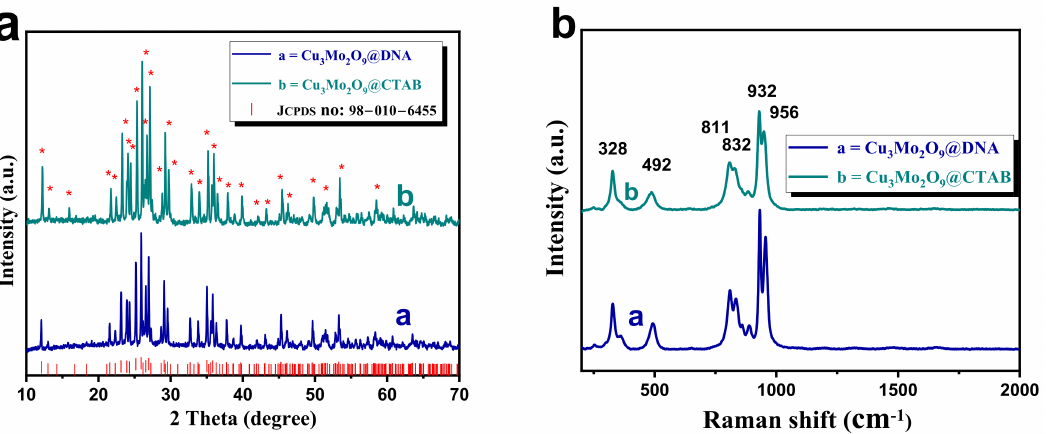
Figure 2. ( a ) Stacked XRD (diffraction peaks marked with red asterisks (*)) of both Cu 3 Mo 2 O 9 @DNA and Cu 3 Mo 2 O 9 @CTAB; ( b ) Raman analysis of both Cu 3 Mo 2 O 9 @DNA and Cu 3 Mo 2 O 9